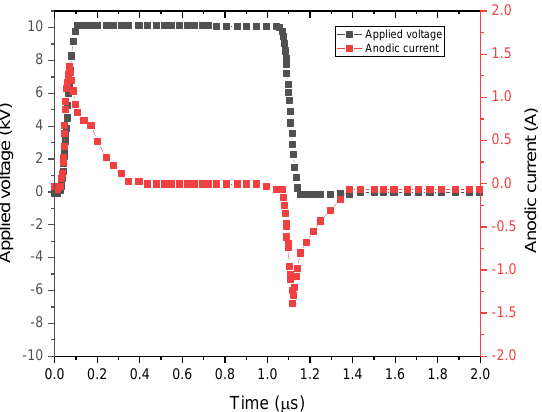
Figure 3. Typical waveforms of the applied voltage and the anode current measurement of the FE-DBD argon plasma supplied at a frequency of 10 kHz, pulse duration 1 µ s, and an applied voltage of 10 kV.